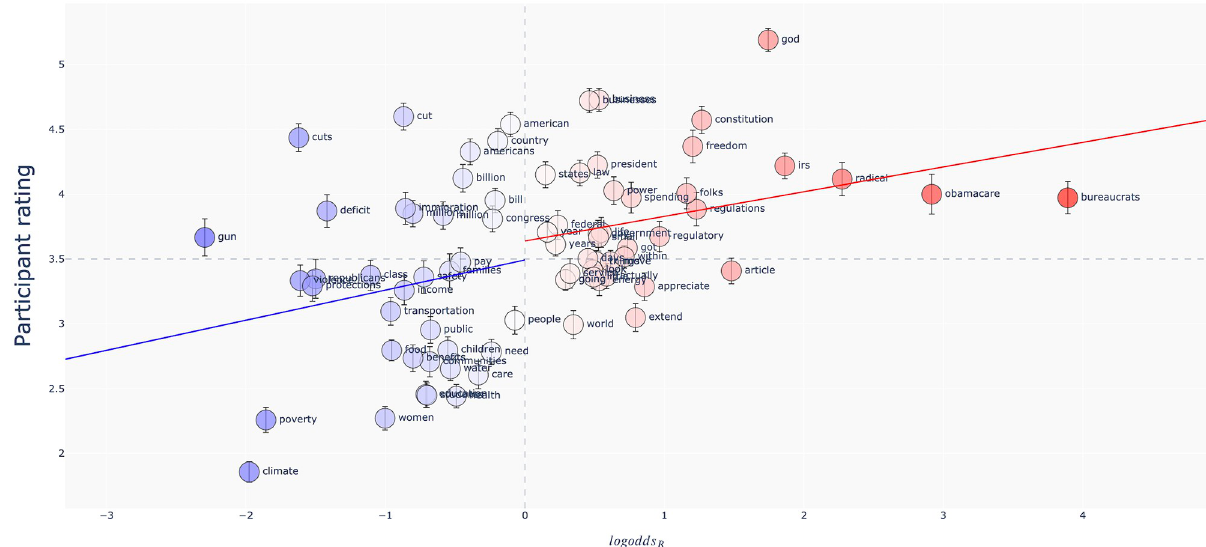
Fig 2. Results of Study 1. The logodds of each word against the average rating given to the word. A rating of 6 corresponds to a judgment of “I am R almost certain the speaker is a Republican,” while a rating of 1 corresponds to “I am almost certain the speaker is a Democrat.” Words are colored by logodds R . Vertical bars mark one standard error around the mean of the ratings. The blue and red lines show the estimated linear trends using only the Democratic items and Republican items, respectively.